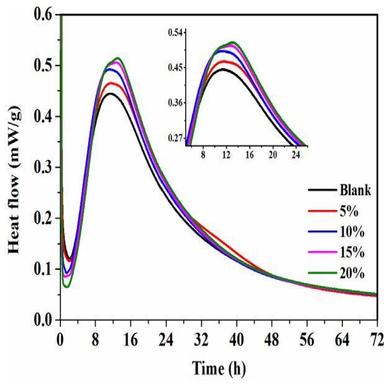
The compressive strength of cement mortars with different dosage of CA/ HAP.